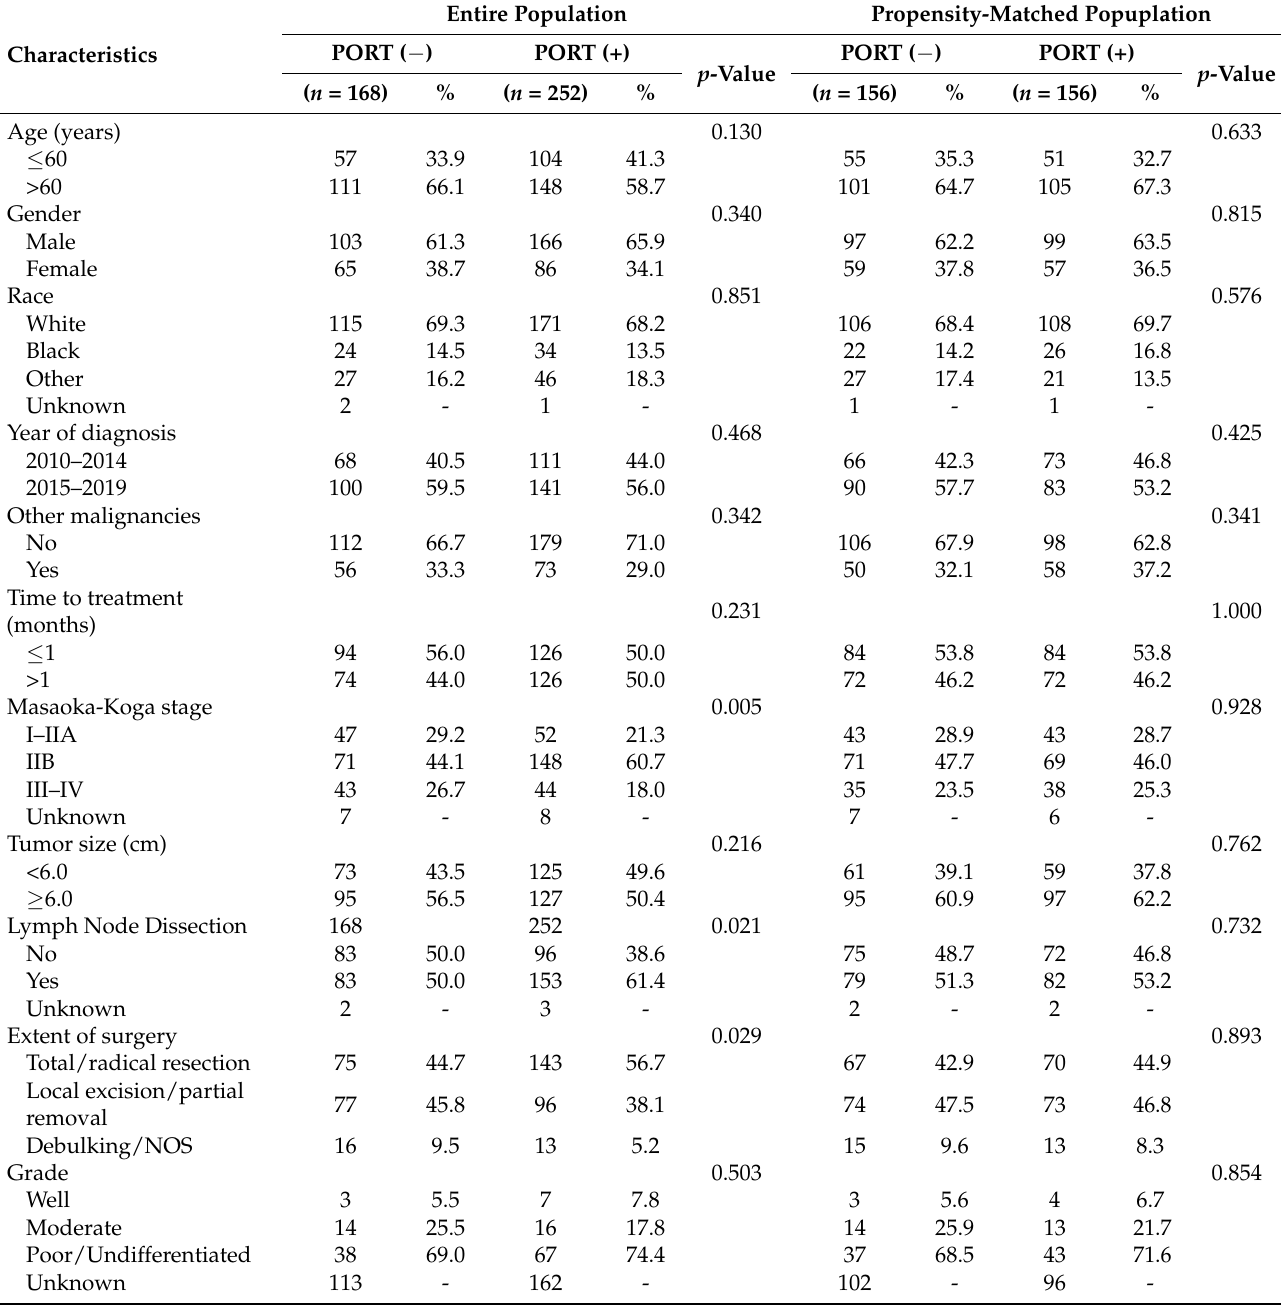
Table 3. Characteristics of thymic carcinoma patients before and after propensity score